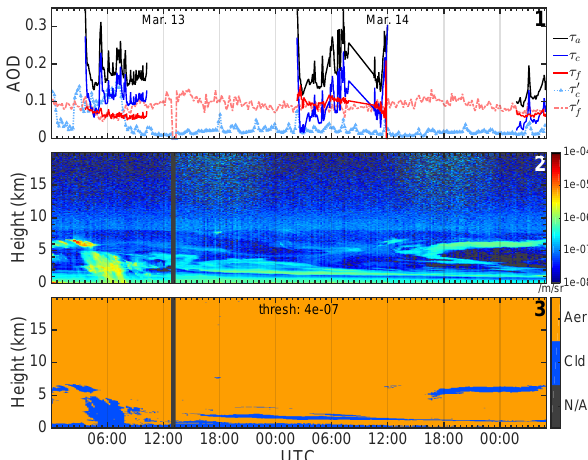
Figure 6. Same pane description as Fig. 2b but for 13– 15 March